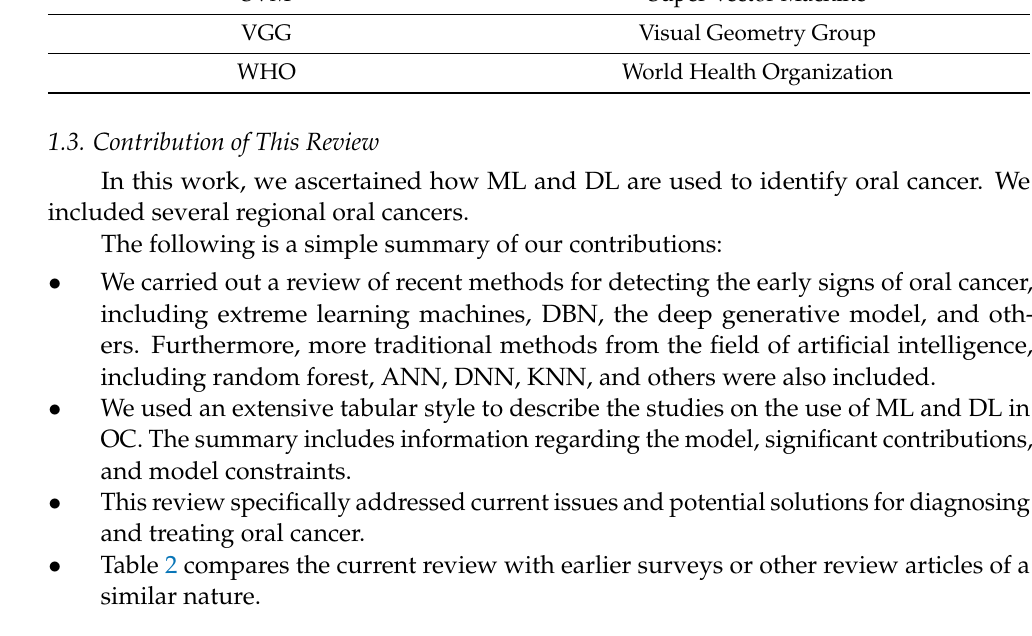
Table 2. Comparison with Prior Surveys/Comparison with Other Review Articles of a Similar